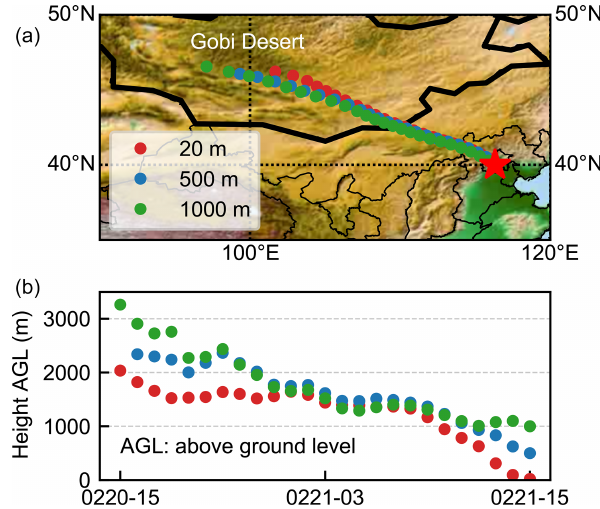
Figure A3. The 24h back trajectory of the air parcel at the sampling site at three different heights (20, 500, and